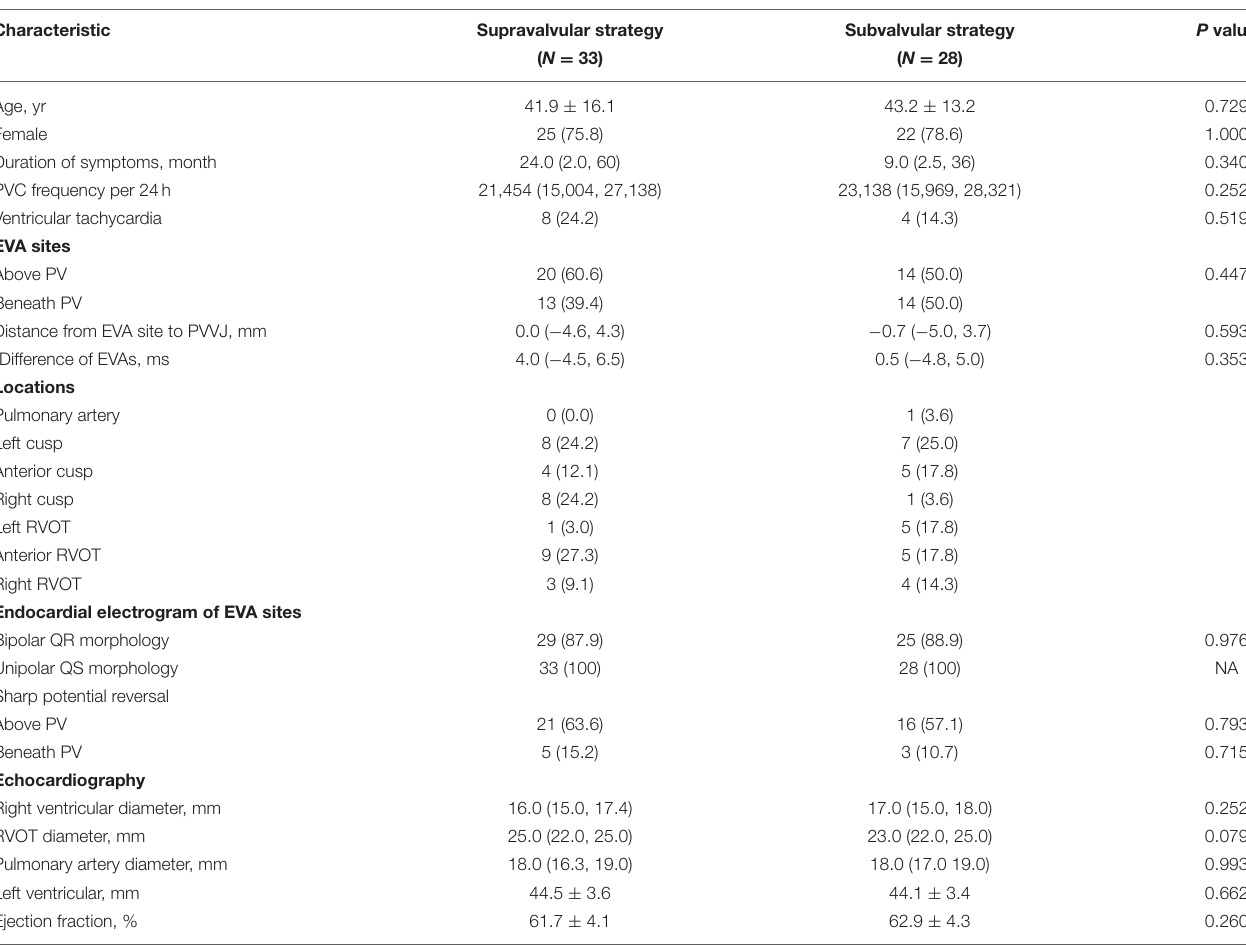
TABLE 1 | Patient characteristics at